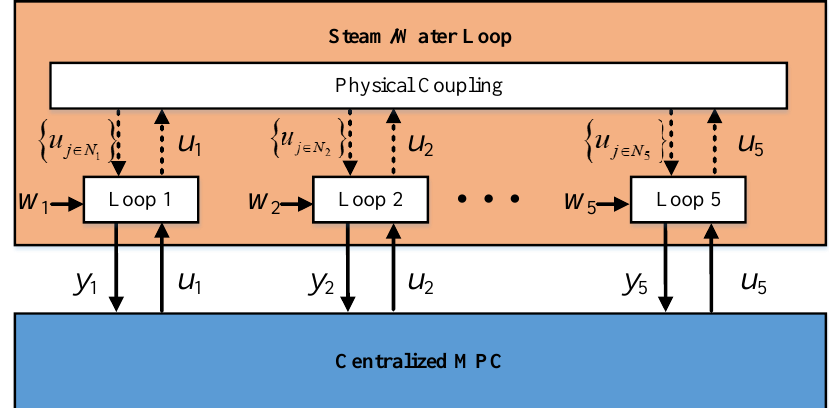
Figure4. Aconceptualrepresentationofthecentralizedmodelpredictivecontrol(MPC)architecture[33] Figure 4. A conceptual representation of the centralized model predictive control (MPC) architecture